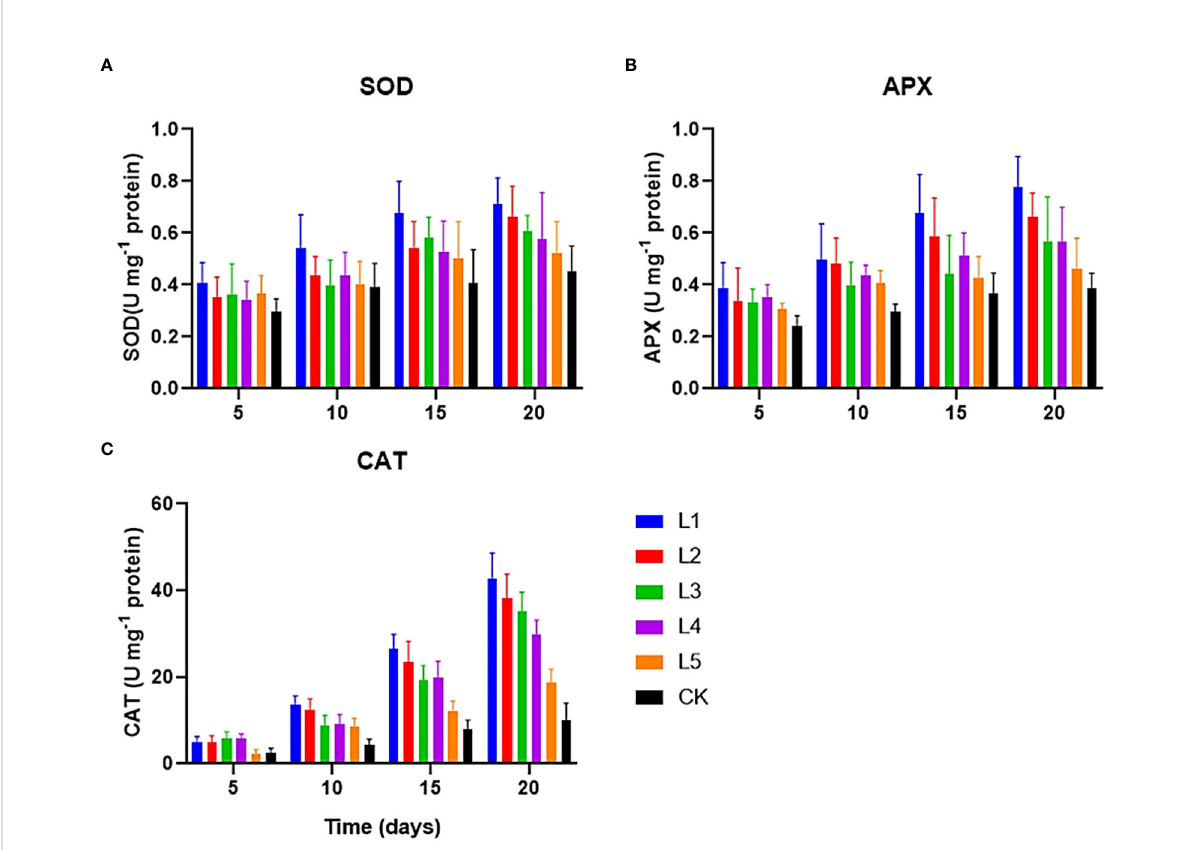
FIGURE 3 The anti-oxidative enzymes [ (A) SOD, (B) . APX and (C) CAT] in L. aequinoctialis exposed to a variety of streptomycin concentrations in the